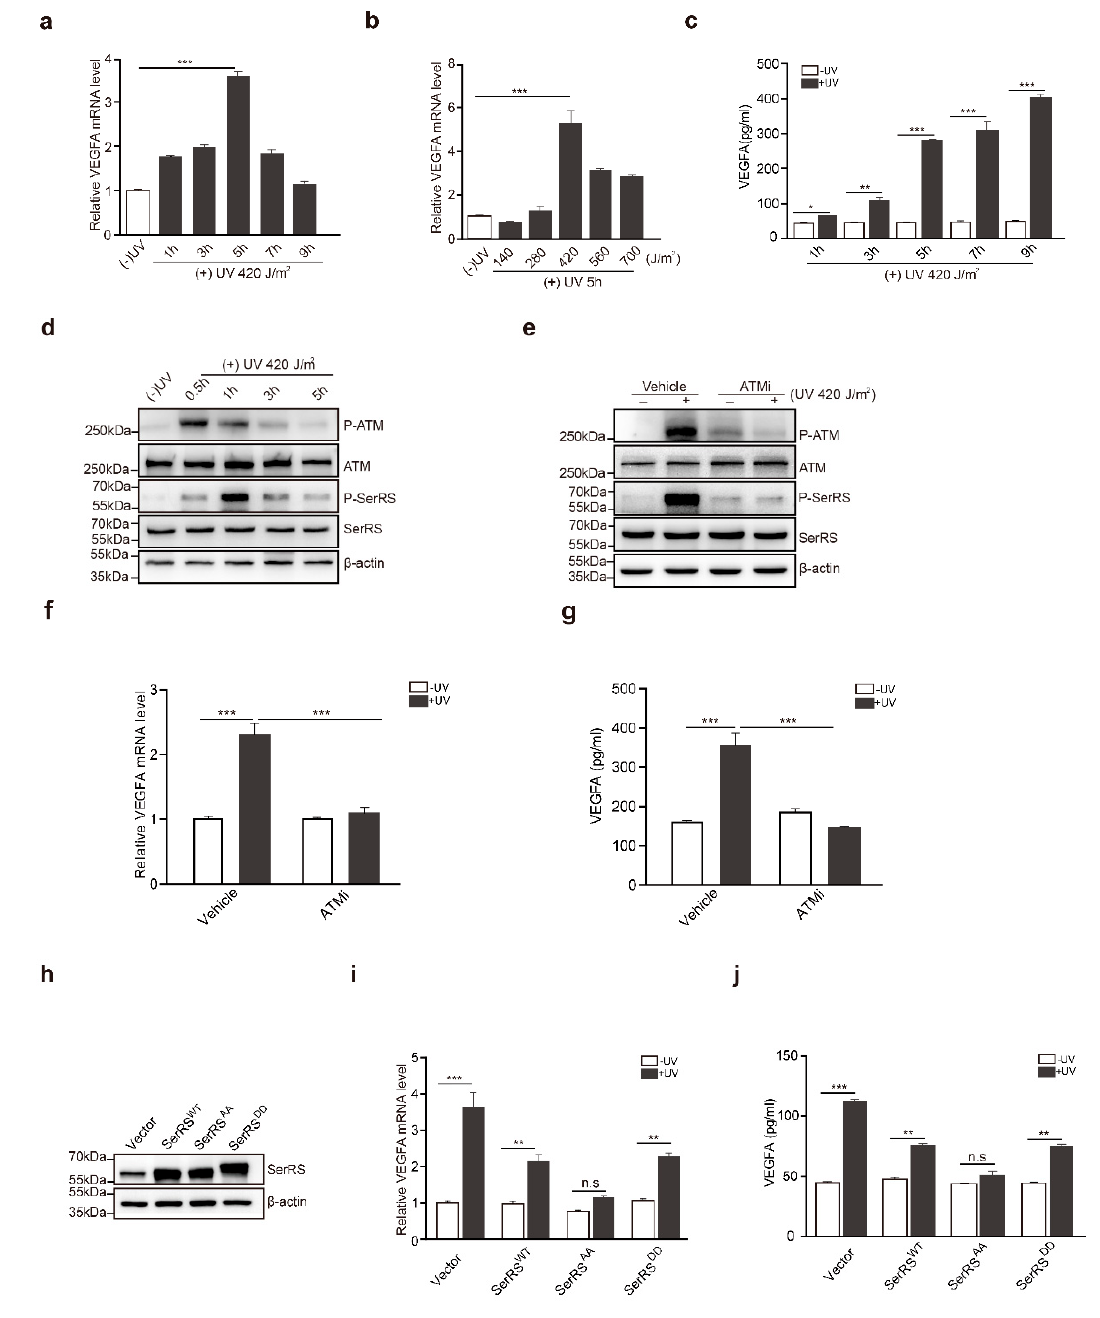
Figure 1. The ataxia telangiectasia mutated (ATM)–seryl-tRNA synthetase (SerRS)–vascular endothelial growth factor A (VEGFA) pathway played an essential role in UV-induced VEGFA expression in HaCaT cells. ( a , b ) mRNA levels of VEGFA were analyzed by RT-PCR. ( c ) VEGFA in supernatants was analyzed via sandwich ELISA. ( d ) Western blot analysis of P-ATM, ATM, P-SerRS, and SerRS expressions in HaCaT cells with or without UV treatment. ( e ) Western blot analysis of P-ATM, ATM, P-SerRS, and SerRS expressions in HaCaT Cells with or without treatments of UV and ATMi. ( f ) VEGFA mRNA levels were detected by RT-PCR. ( g ) VEGFA in supernatants was analyzed via sandwich ELISA. ( h ) Western blot analysis of SerRS expression; β -actin served as a loading control. ( i ) mRNA levels of VEGFA were analyzed by RT-PCR. ( j ) VEGFA in supernatants was analyzed via sandwich ELISA. All data above are presented as means ± SEM ( n = 3, * p < 0.05, ** p < 0.01, *** p < 0.001) of three independent repeats.